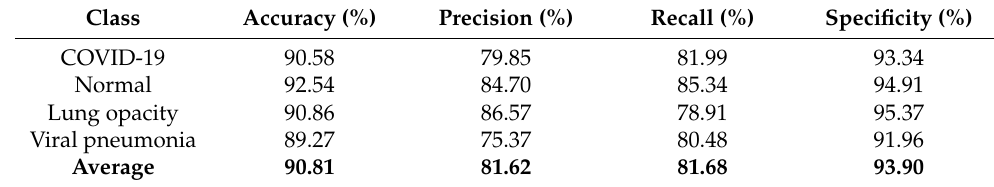
Table 4. Classification performance for the test CXR images in Fold 1 using LBP ‐ based SVM. Class Table 5. Classification performance per-fold for the test CXR images using LBP-based SVM. Fold Accuracy (%) Precision (%) Recall (%) Specificity